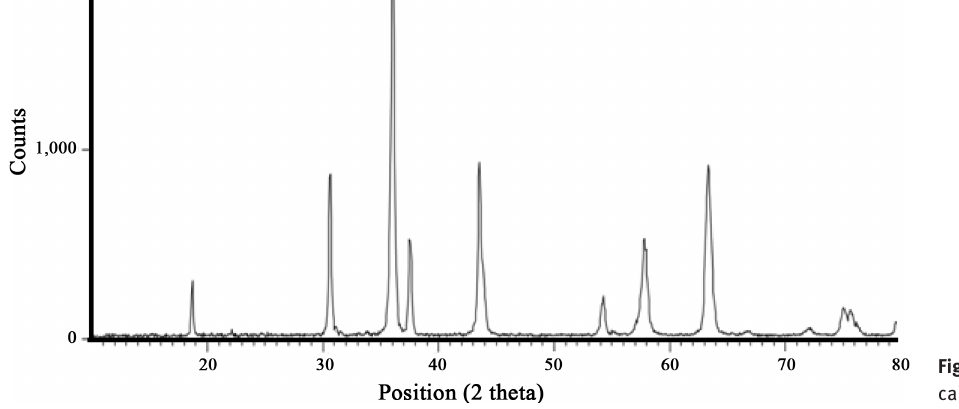
(Figure 4) as a function of magnetic field. The magnetiza- tion parameter obtained ~0.2 emu/g in 8kOe applied field